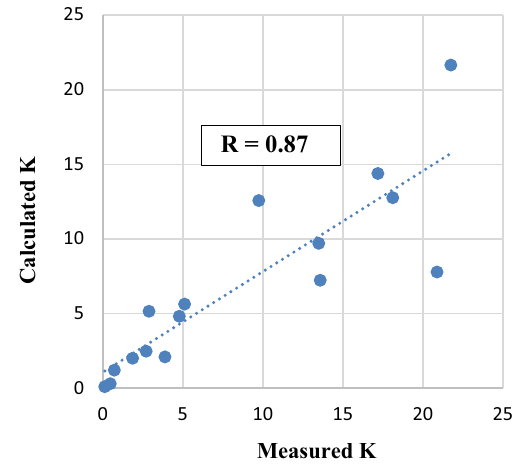
Fig. 14 Cross-plot of measured permeability versus calculated one of HFU